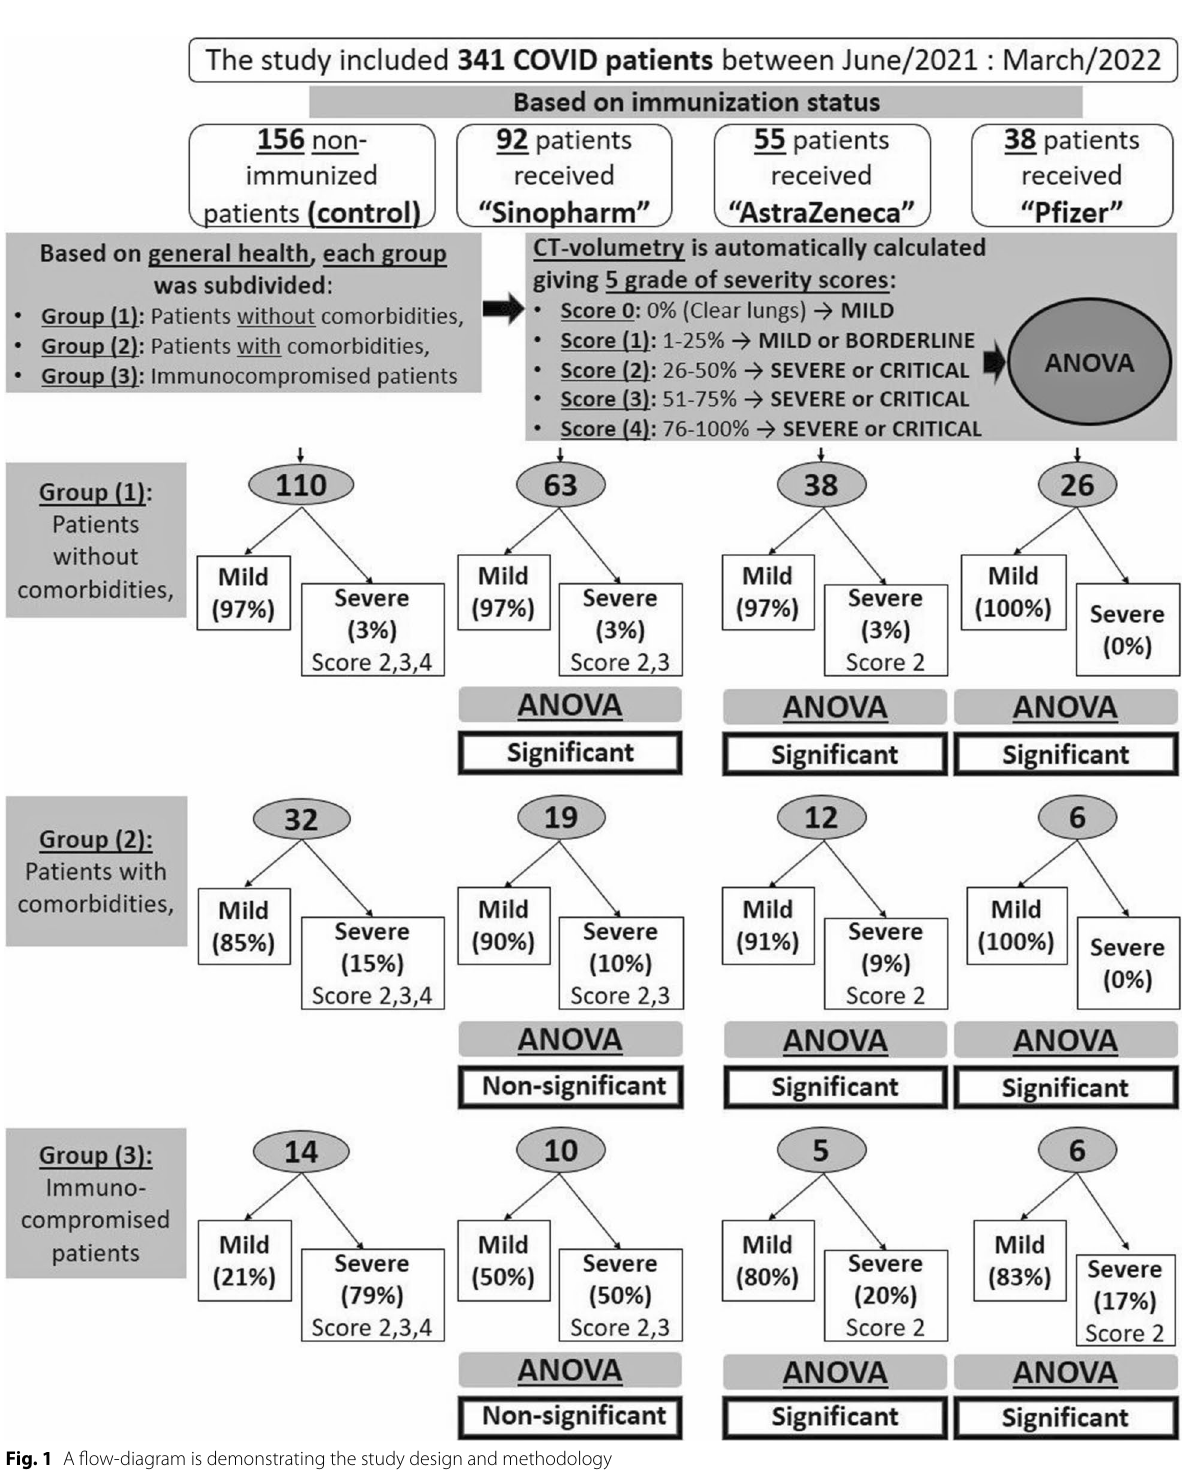
Fig. 1 A flow‑diagram is demonstrating the study design and